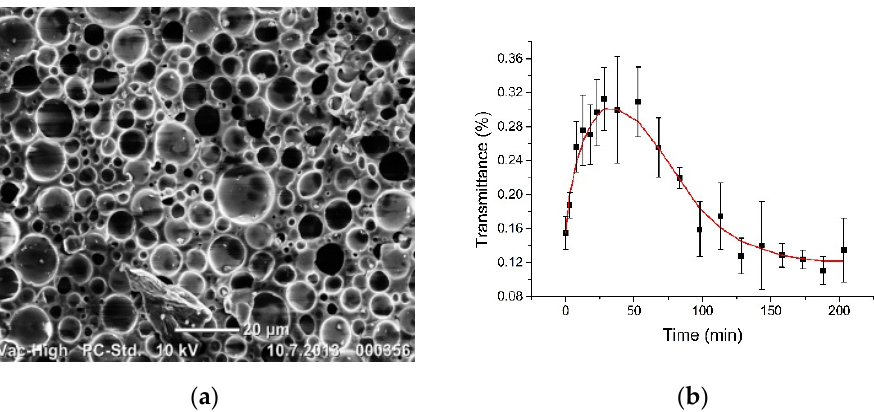
Figure 4. ( a ) SEM of the internal structure of the nanoparticle-free silicone-glycerol phantom; ( b ) the kinetics of collimated transmittance averaged for spectral band 600 – 800 nm and presented as (mean ± SD) at impregnation of the sample by distilled water ( b ).